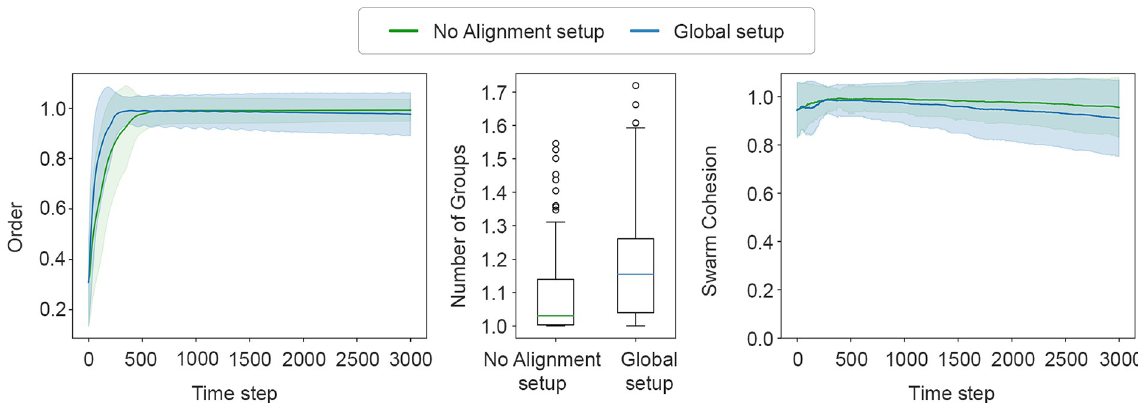
Fig 9. The metric scores achieved by the highest-scoring controller of the No Alignment setup and the Global setup . Left: The order metric. Centre: the number of groups metric. Right: the swarm cohesion metric. The shaded areas indicate the standard deviation.